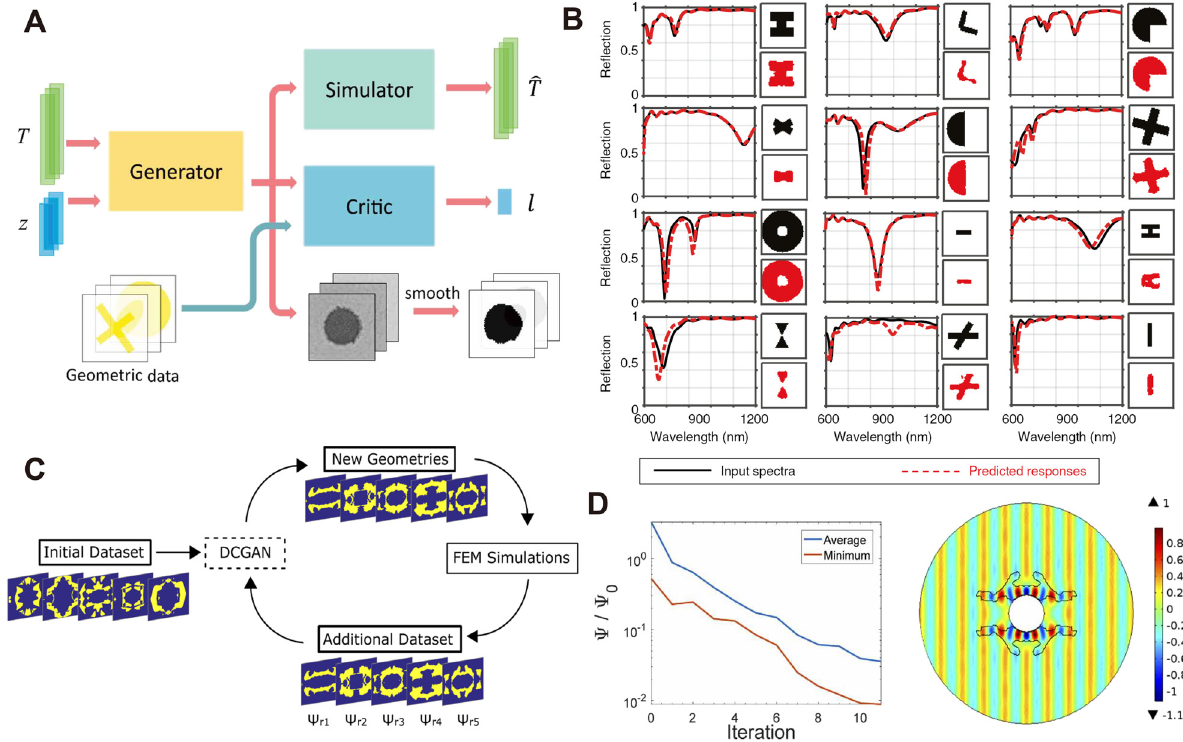
Figure 5: Generative adversiral network (GAN) implemented in nanopotonic inverse design (A) GAN’s generic schematic applied in nanophotonic design, which includes a generator, discriminator(also known as critic), and simulator. The generated device pattern is further optimized for fabrication by a smoothing procedure. Adapted from [108]. (B) A GAN-based silver structure design under arbitrary reflection spectra. The panel shows nine examples of device binary images generated by GAN and the corresponding reflection spectra as condition (solid line) and predicted response (dash line). Adapted from [110]. (C) Basic training strategy of GAN in the design of optical cloaks. The panel shows a successive data augmentation technique, where FEM simulations evaluate the newly generated geometries to complement the initial dataset. (D) Left: average and minimal scattering coefficient among the top-1000 configurations generated by the network. Right: the scattered field in an optimized 2-dimensional optical cloak. (C) and (D) are adapted from